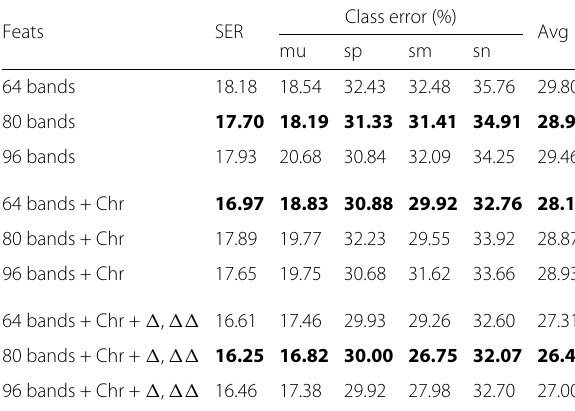
1BLSTM RNN classifier on the test partition for different frontend configurations (Chr, chroma; (cid:4) , (cid:4)(cid:4) , 1st and 2nd